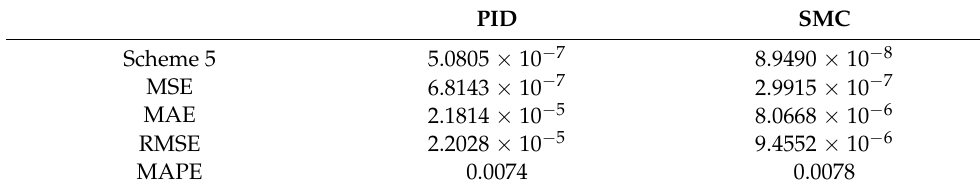
Table 5. Comparison of slope response